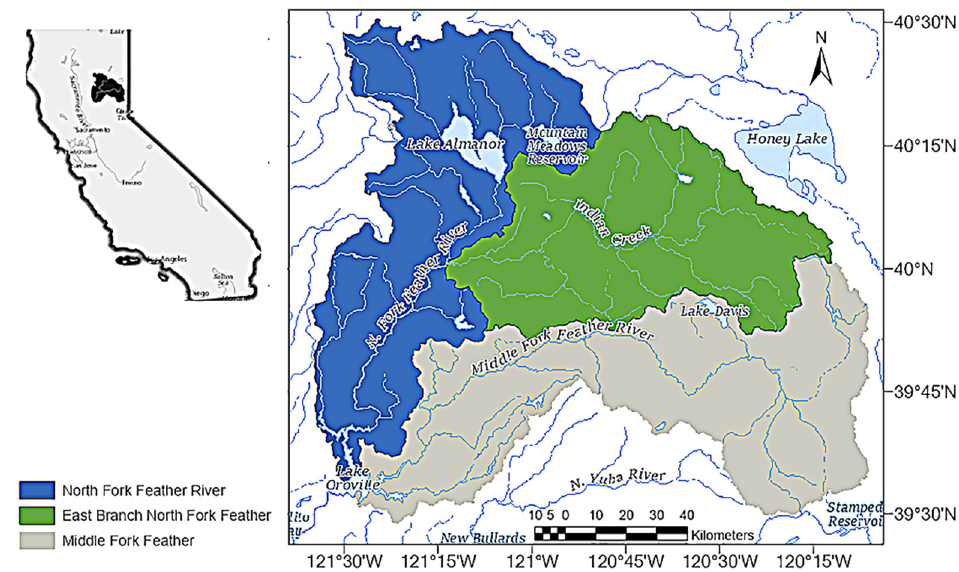
Figure 1. Maps of California and the Feather River basin.